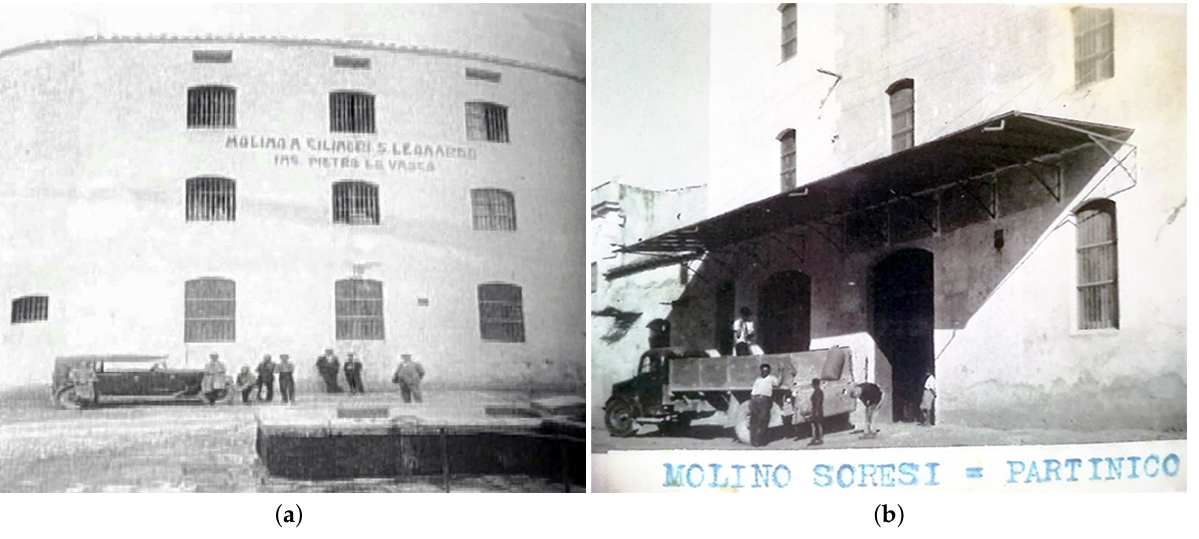
Figure 2. Historical photos. ( a ) Cylinder mill “San Leonardo” by Eng. Pietro Lo Vasco; ( b ) Mill “Nicolò Soresi and